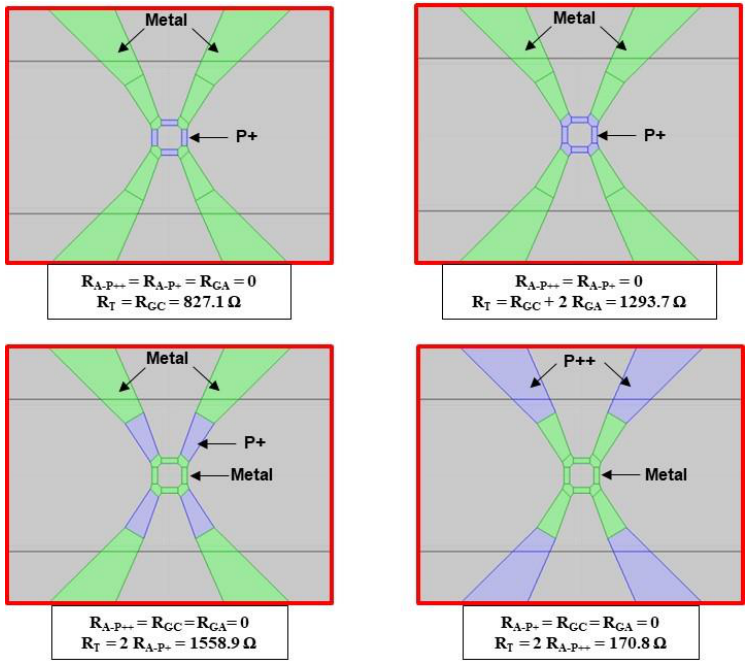
Figure 16. Four cases simulated using COMSOL software to determine the resistances (green: Metal; blue: P + or P ++ ). Table 4. Values of the different resistances shown in Figures 13 and 14 and those derived from COMSOL simulations.